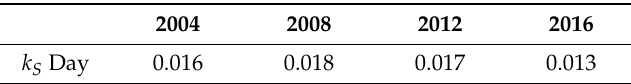
Table 3. Parameter k S (1/km) for LST n .